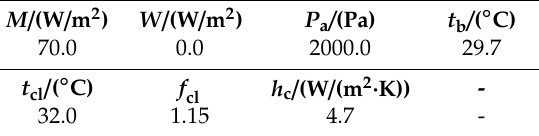
Table A5. Parameters of the PMV index.